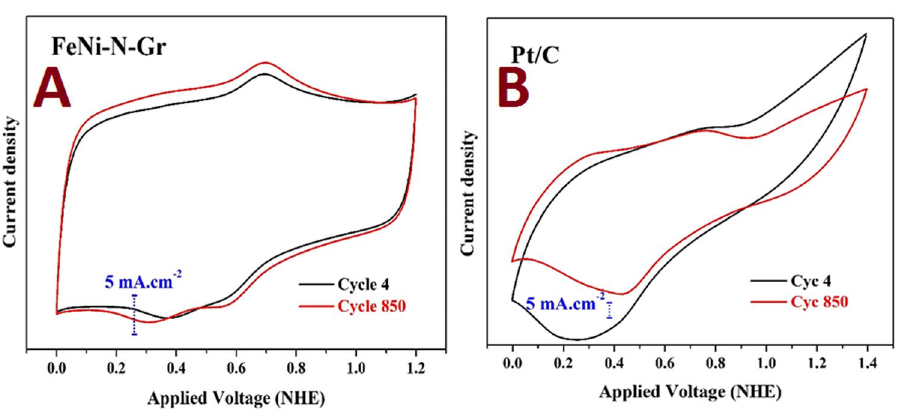
Figure 4. Comparison between the 4 th and 850 th cycles for the ( A ) introduced FeNi- N-Gr and ( B ) Pt/C electrodes. The data were extracted from 1,000 cycles in 0.5 M H 2 SO 4 (scan rate 50 mV.s − 1 at room